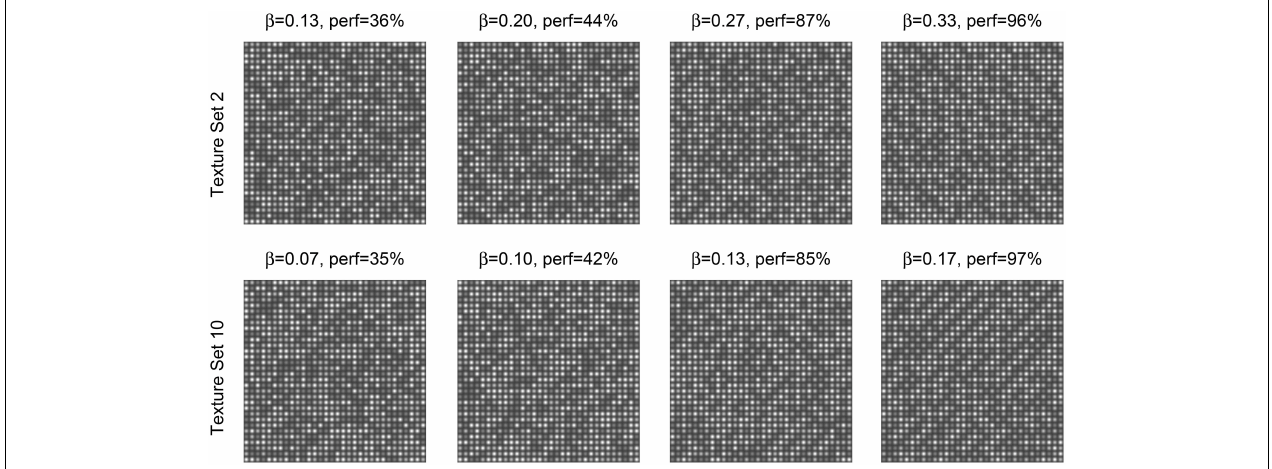
FIGURE 2 | Examples of generated textures from sets 2 and 10 for different values of β . In the image title the value of β and the average human performance in Experiment 2 are